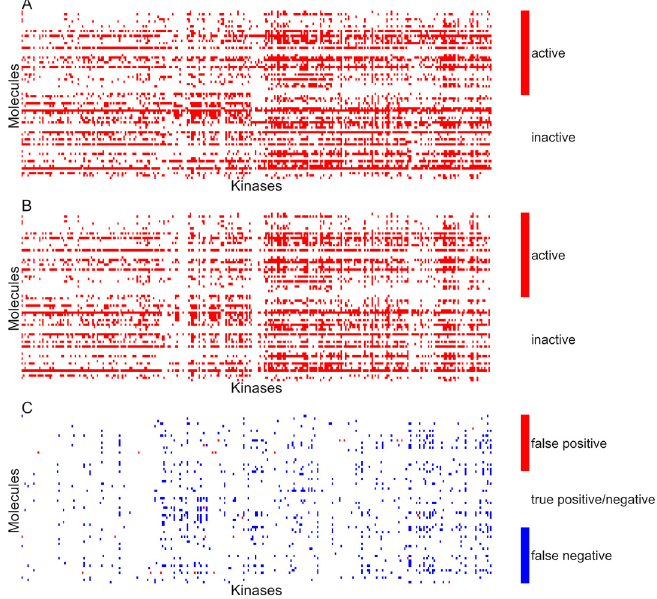
Figure 5. Activity matrix of all inhibitors versus all kinases. ( A ) Experimental activity matrix as reported by Davis and colleagues. The pixels in red correspond to active molecules at 10 µM; ( B ) Predictions made by quantitative structure–activity relationship (QSAR) model. Pixels in red correspond to compounds predicted as active; ( C ) Difference of experimental activity matrix and prediction activity matrix. Pixels in red correspond to false positive predictions while those in blue correspond to false negatives. White-colored pixels correspond to correct predictions (20,813 out of 26,580) made by the QSAR model.